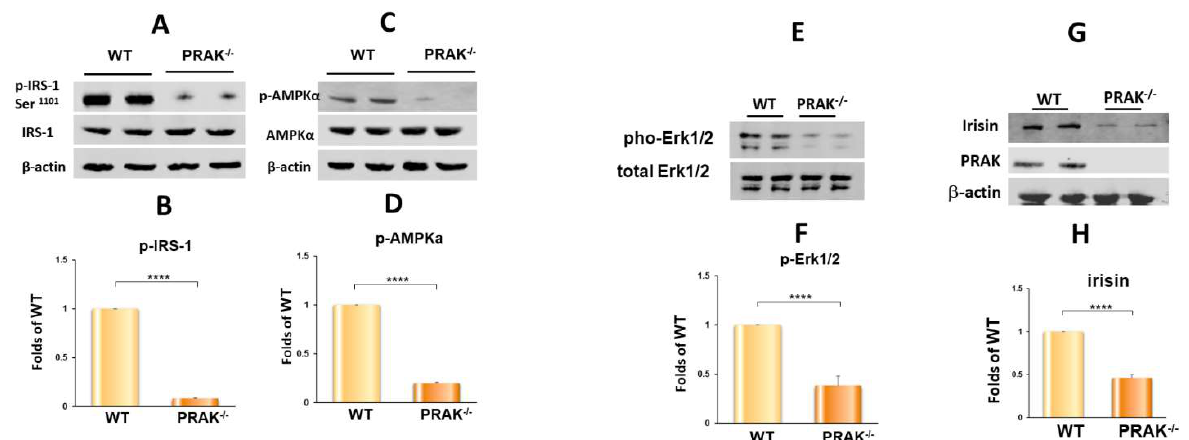
Figure 7. PRAK deletion decreases phosphorylation of IRS-1, AMPK α , and ERK1/2 in the myocardium. ( A , B ) Representa- tive immunoblot of phosphorylated IRS-1 and total IRS-1 and densitometric analysis; ( C , D ) Representative immunoblot of phosphorylated AMPKα and total AMPKα and densitometric analysis; ( E , F ) Representative immunoblot of phosphorylated ERK1/2 and total ERK1/2 and densitometric analysis; ( G , H ) Representative immunoblot of irisin, PRAK and densitometric analysis of irisin; Data represent means ± SE ( n = 4/ per group). **** p < 0.0001.